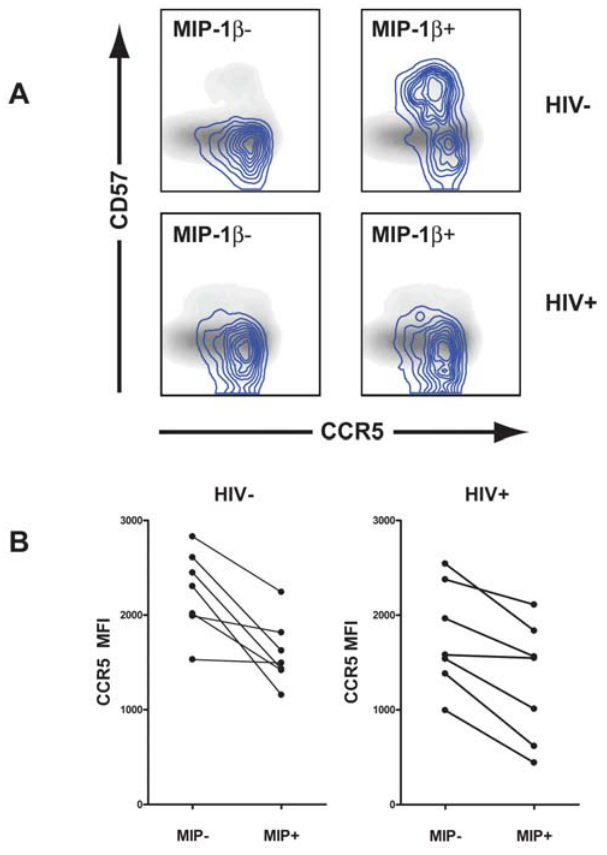
Figure 5. MIP-1 b producing pp65-specific CD4 + T cells have lower surface expression of CCR5. A) pp65-specific CD4 + T cells which either produce or do not produce MIP-1 b are overlaid onto a 2 dimensional histograph of memory CD4 + T cells plotted against CD57 and CCR5 surface expression for a representative HIV-uninfected and HIV-infected individuals. MIP-1 b + and MIP-1 b 2 memory CD4 + T cells, shown by blue isobars, are overlayed on 2 dimensional density plots showing expression of CCR5 and CD57. B) For all seven of the non-HIV and all seven of the HIV infected individuals, pp65 specific CD4 + T cells which produced MIP-1 b had lower MFIs for CCR5 surface expression than cells which did not produce MIP-1 b ( P , 0.05).